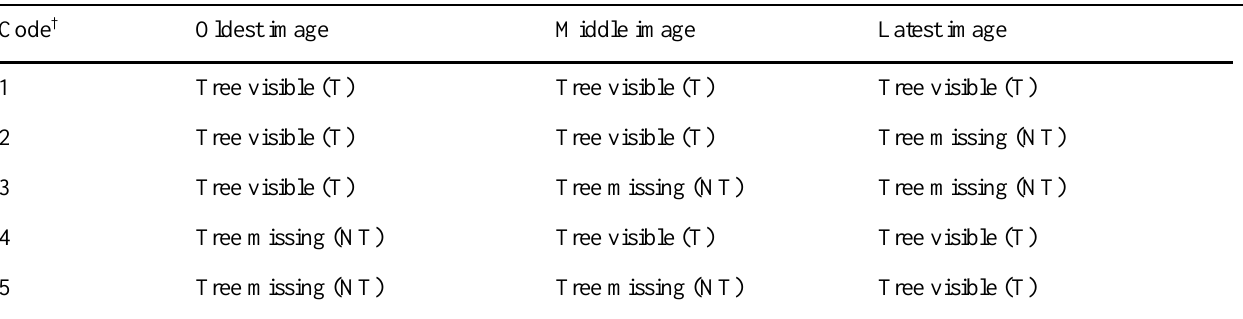
Table 1 . Criteria table for the three-date image processing showing changes in tree